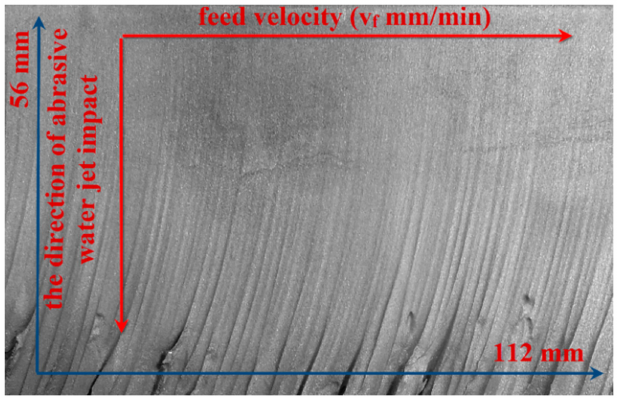
Figure 1. Surface of a AZ91D specimen after